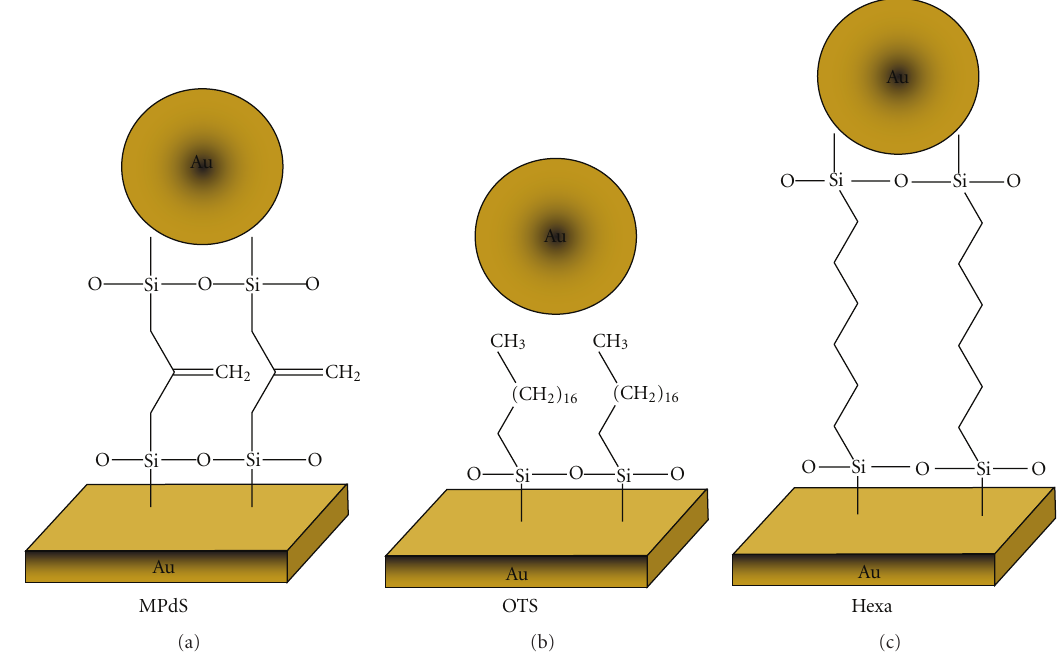
Figure 1: Schematic description of the organic molecules that were used for the SAM on Au or Nb